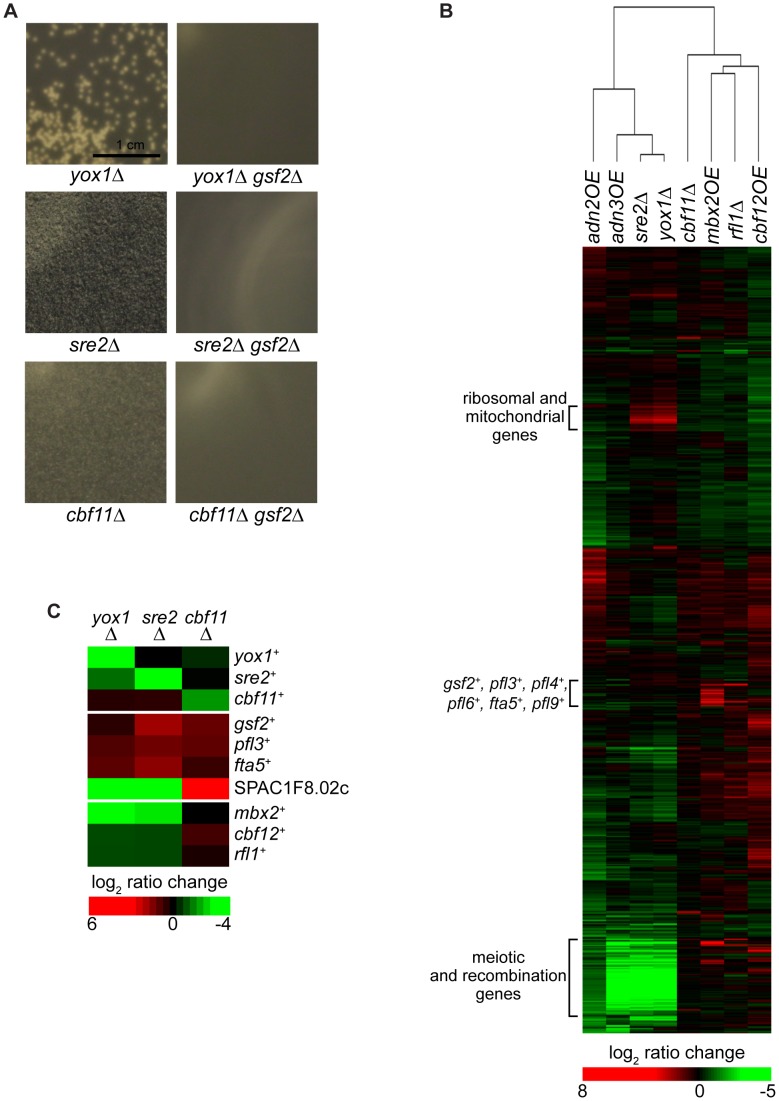
Regulation of flocculation by Yox1, Sre2, and Cbf11.(A) The regulation of flocculation by Yox1, Sre2 and Cbf11 is dependent on gsf2+. yox1Δ, sre2Δ and cbf11Δ cells flocculate in late log and stationary phase when grown in YES medium (left panels). The flocculation of these mutant strains was abrogated in the gsf2Δ background (right panels). (B) Clustergram of microarray expression profiles of flocculent transcription factor mutants. The microarray expression profiles of the yox1Δ and sre2Δ strains are most similar and show upregulation of ribosomal and mitochondrial genes. (C) The yox1Δ, sre2Δ and cbf11Δ flocculent strains show upregulation of several flocculin genes. The color bars reflect relative expression between experimental and control.